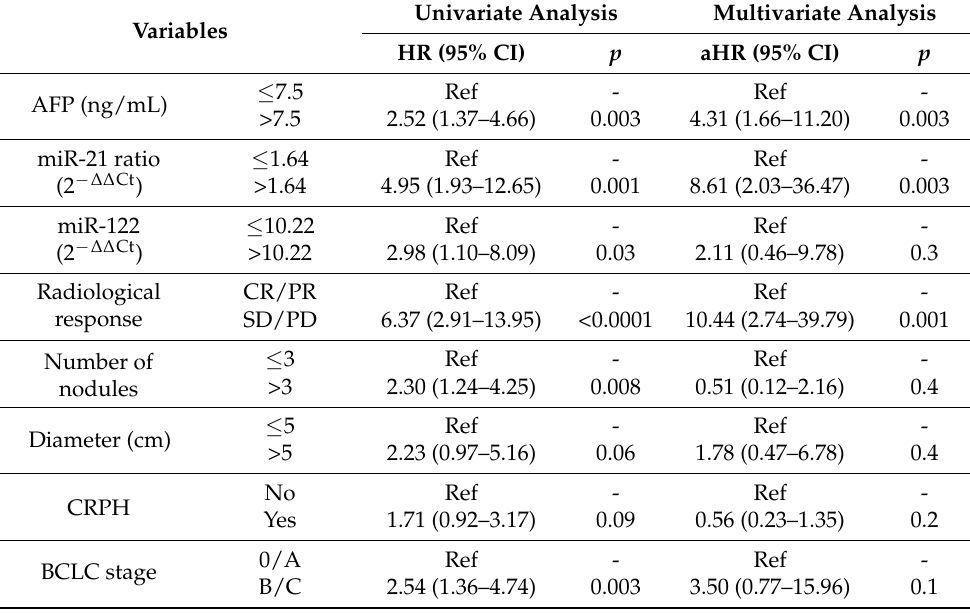
Table 2. Univariate and multivariate Cox analysis for factors independently associated with